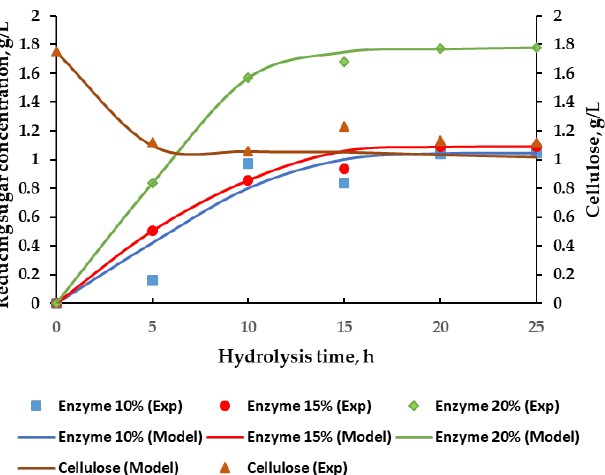
Figure 1. Changes in the reducing sugar and cellulose concentration in hydrolysate dur- ing enzymatic hydrolysis of pre-treated rice husk at various cellulase loadings. All ex- periments were carried out in